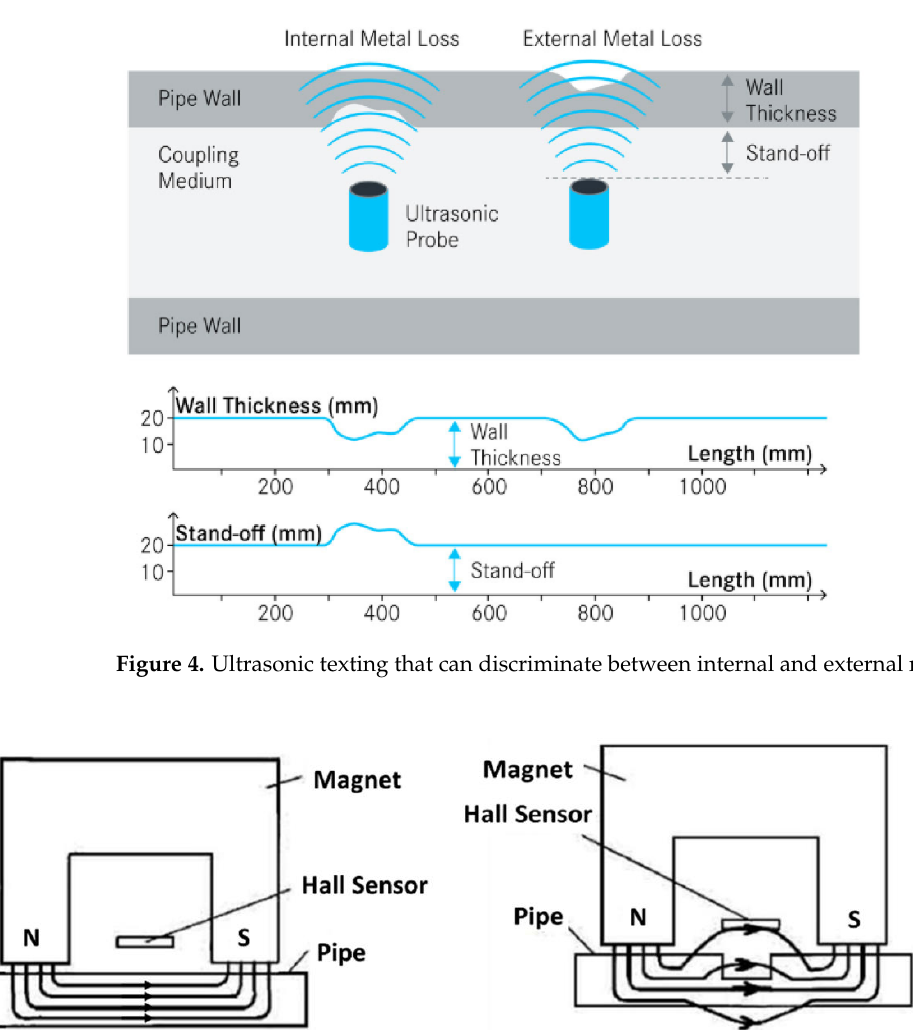
Figure 3. Variations of the electrochemical sensors. Reproduced with permission from [77] Copyright 2019 AIP Publishing. 3.1.4. Ultrasonic Testing Sensor One of the most common methods that monitors the extent of corrosion and the struc- tural health of the pipes is the method where ultrasonic testing (UT) wall thickness is measured. Acoustic waves that have a high frequency, of the order of MHz, are generated from a piezoelectric transducer. The direction in which these waves are emitted is in a direction perpendicular to the pipe wall. The transducer receives the waves, which are reflected from various surfaces such as the internal and external surface of the pipe. The wall thickness is calculated by measuring the time difference between two consecutive echoes from the outer and inner surfaces of the pipe [78–80]. The data of wall thickness